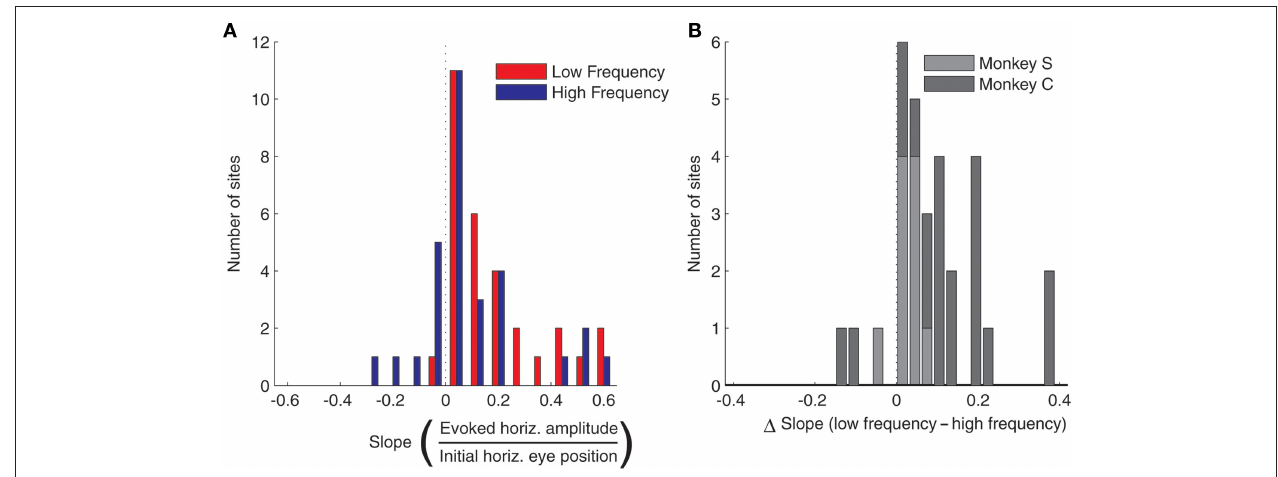
component of amplitude parallel to the axis of the array of fixation LEDs was used for this analysis. (B) Differences in slope between low and high frequency conditions. Results were similar in the two monkeys, as indicated by different shades of gray.